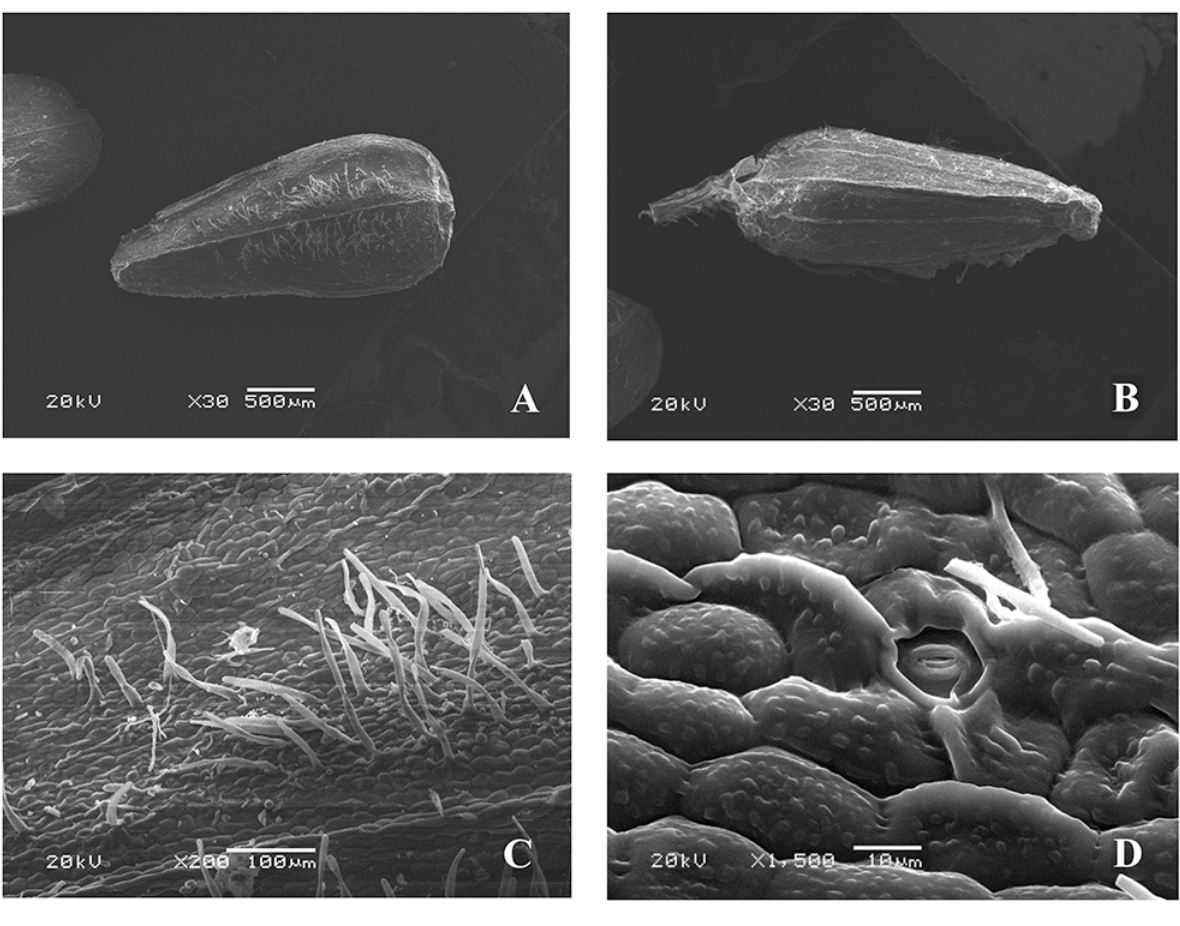
Figure 10 Fruits of Valeriana rossica P. Smirn. (SEM): General view, adaxial side ( A ); general view, abaxial side ( B ); fragments of the fruit ( C ); stomium ( D